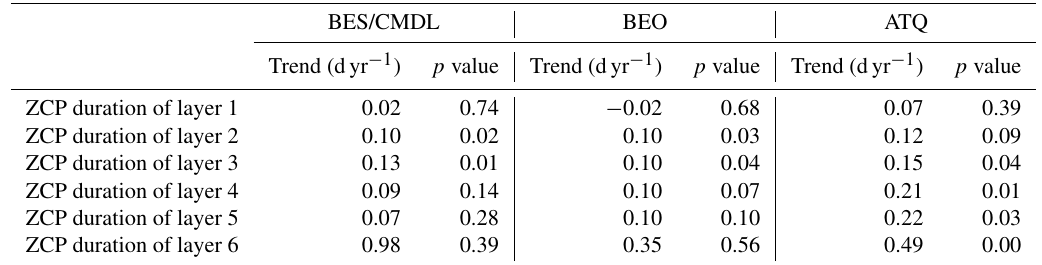
Table 5. Historical trend of ZCP durations (daysyear − 1 ) for each soil layer from 1950 to 2017. (Trends with p> 0 . 05 are not statistically significant.)